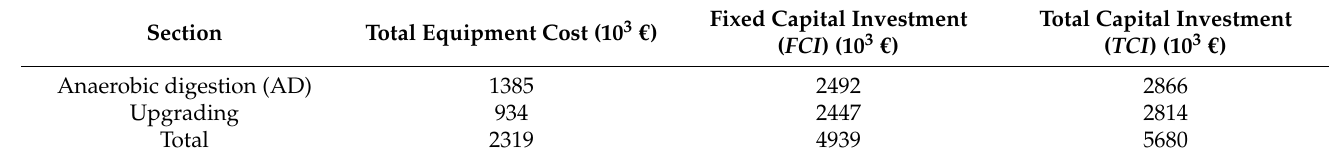
Table 4. Breakdown of the total capital investment for each section of the